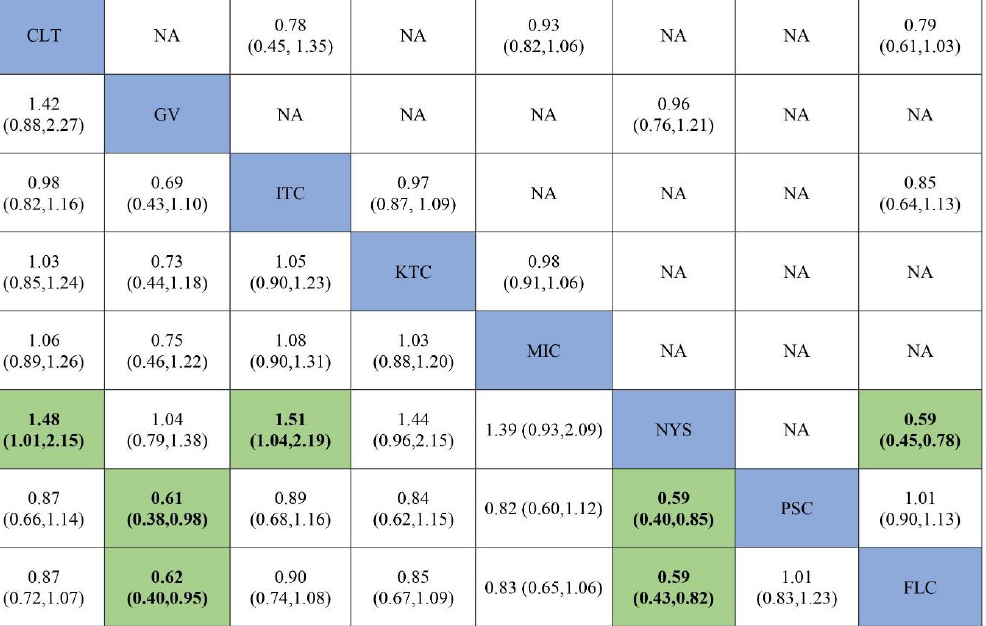
Figure 5. Comparative efficacy of antifungal agents used for the treatment of OPC among HIV-infected adults (clinical cure). Note: pairwise (upper right portion) and network (lower left portion) meta-analytic results. Outcomes are expressed as risk ratio (95% confidence intervals). For the pairwise meta-analyses, a relative risk of more than 1 indicates that the treatment specified in the row is more efficient. For the network meta-analysis, a relative risk of more than 1 shows that the treatment specified in the column is more efficient. Bold and green shaded results indicate statistical significance.